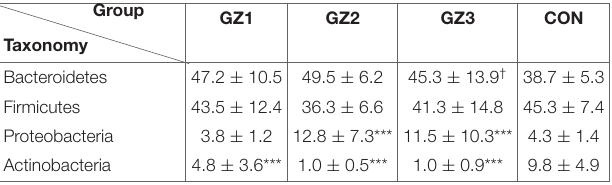
TABLE 2 | Statistical table of organ involvement in children with IgA vasculitis. Skin